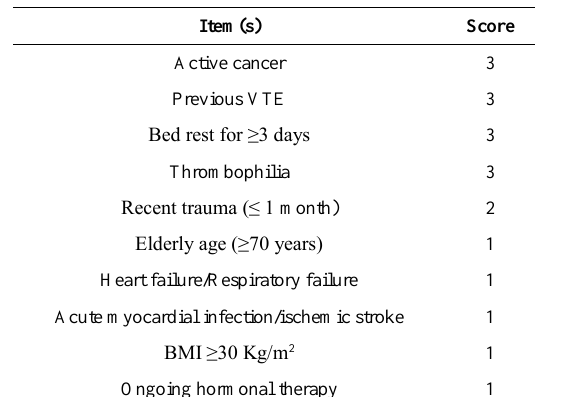
Table 1. Padua prediction score assessment tool: High risk VTE score: ≥ 4